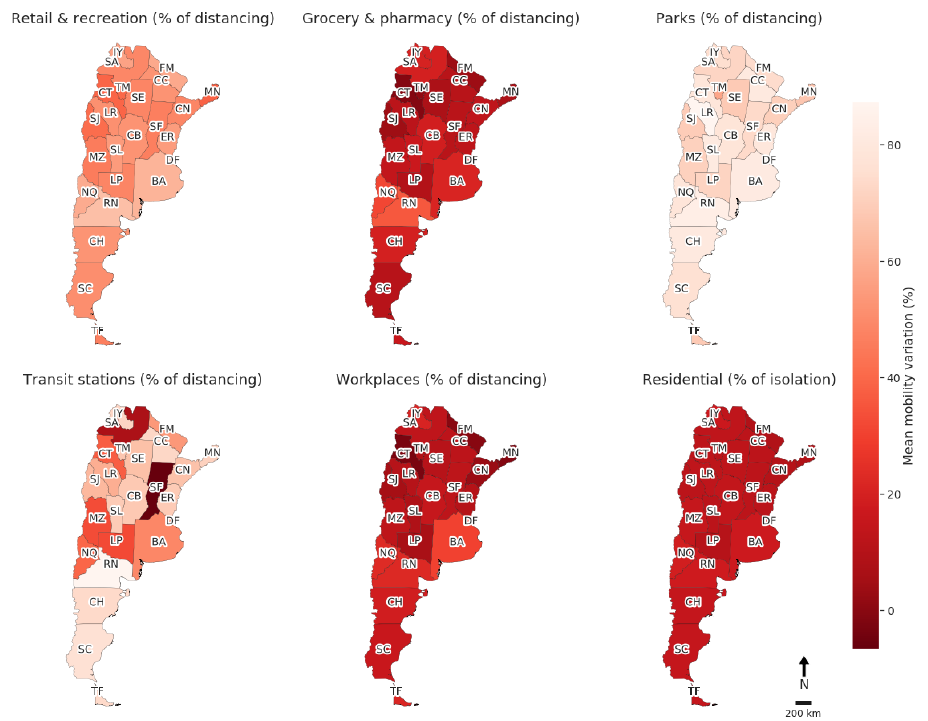
Figure 14. Average variation of mobility from baseline (3 January to 6 February 2020) for the provinces of Argentina during the period from 1 June to 27 October 2020. Lighter colours indicate greater distancing or greater isolation in residential areas. Source of basic data: Covid-19 Community Mobility Reports,